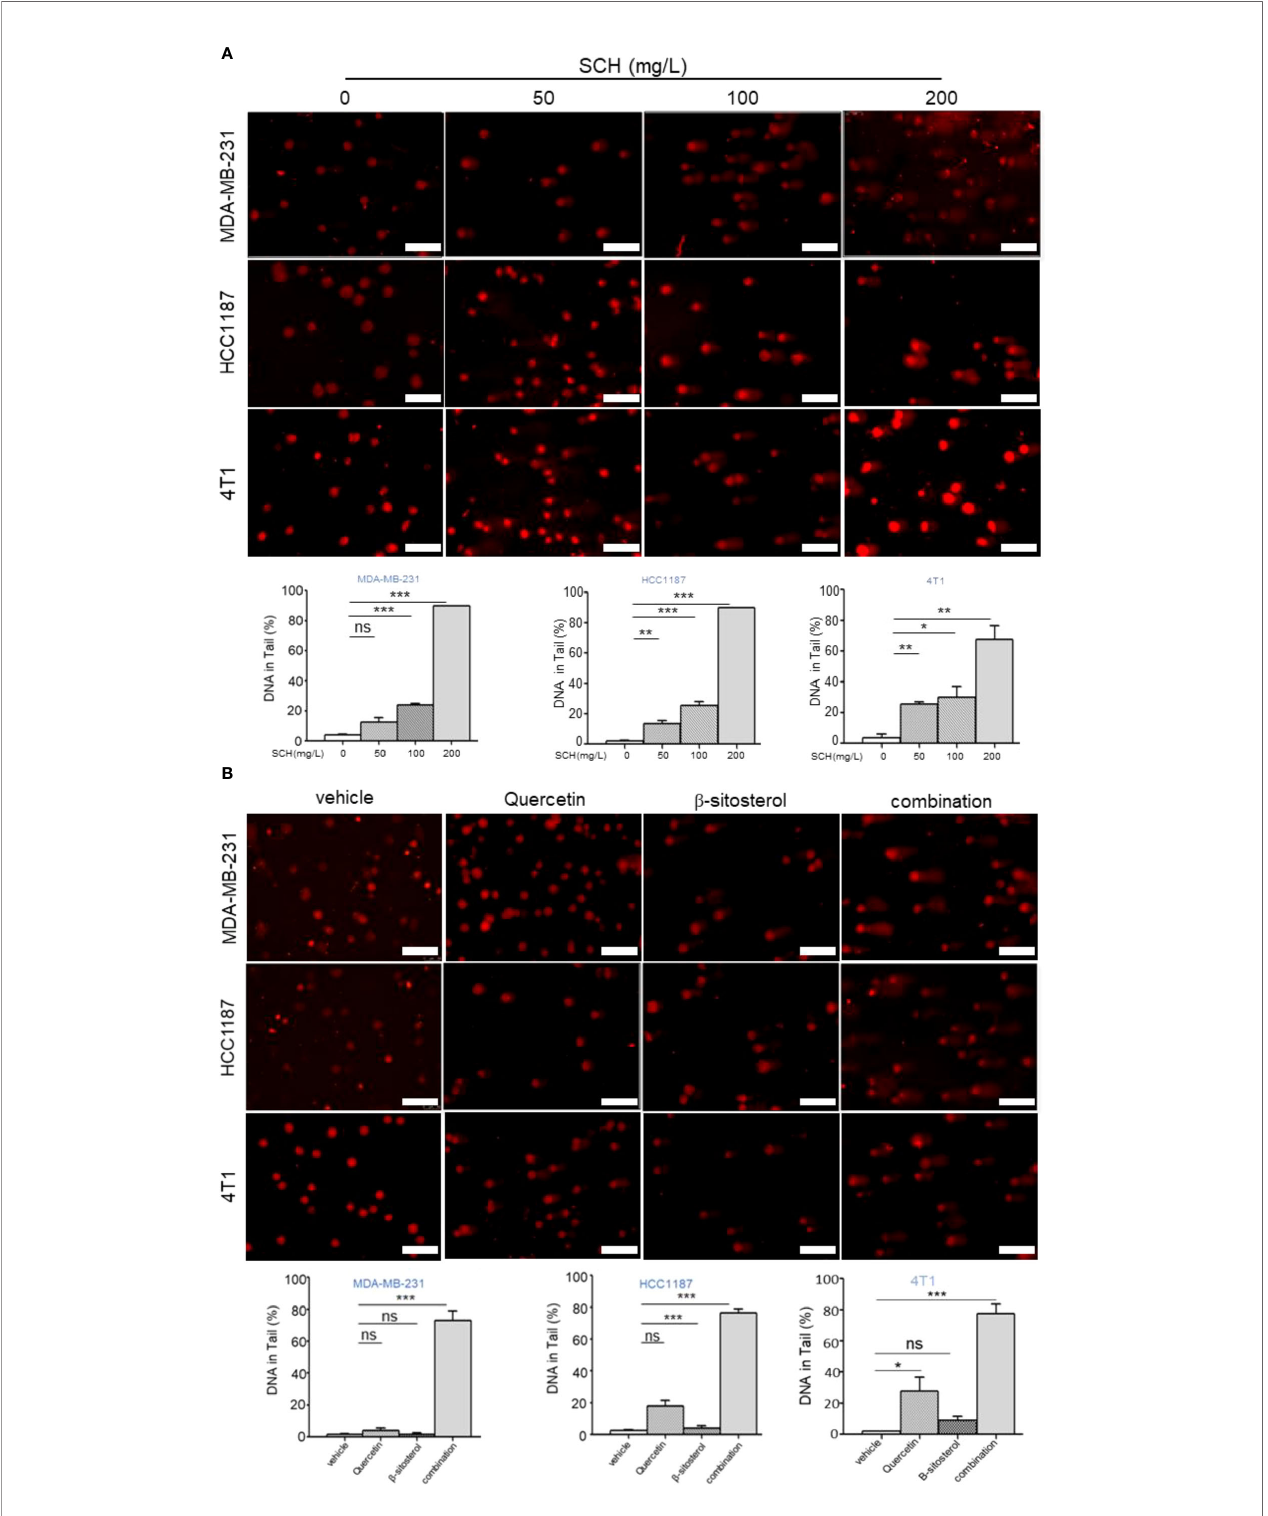
FIGURE 6 | SCH treatment induces DNA damage via the synergistic effect of quercetin and b -sitosterol. (A) Comet assay (scale bar, 100 m m) was executed to appraise DNA damage in TNBC cells administered with varying dosages of SCH for 48 h. (B) Comet assay (scale bar, 100 m m) was performed to evaluate DNA damage in TNBC cells treated with quercetin and/or b -sitosterol for 48 h. The DNA quanti fi cation in the tail from three separate trials is revealed as mean ± S.D., ns- not signi fi cant, *P < 0.05, **P < 0.01, ***P < 0.001 (Student ’ s t